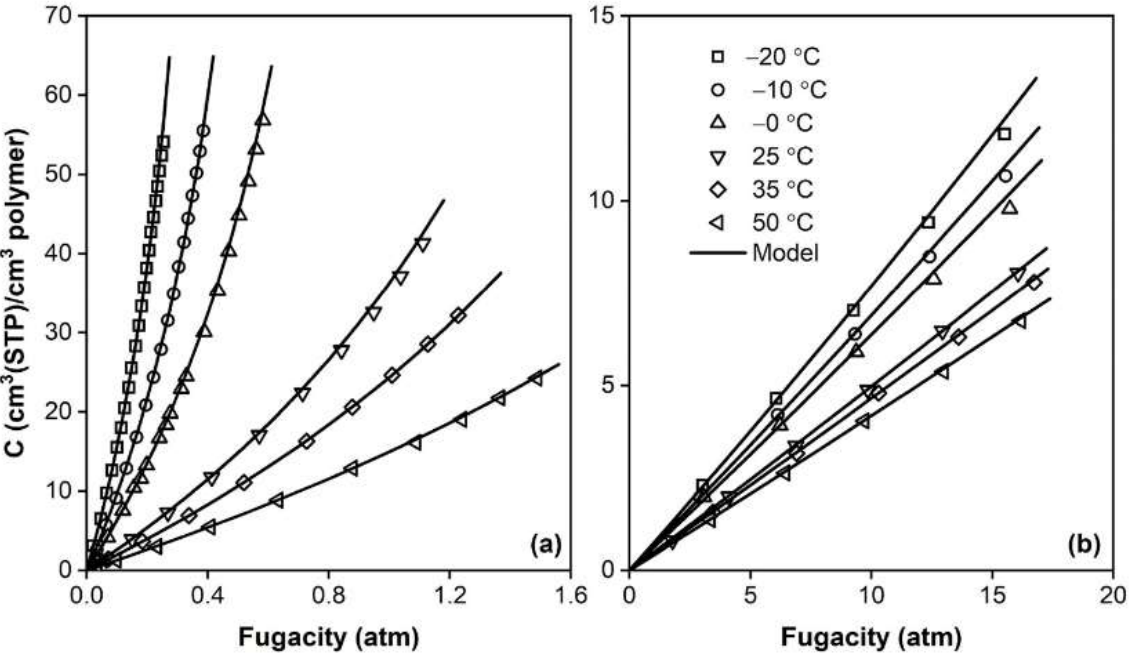
Figure 6. Example application of the PC-SAFT model to calculate ( a ) n-C 4 H 10 and ( b ) CH 4 sorption isotherms as a function of temperature [137]. Experimental data from [47]. Reprinted with permission from [137]. Copyright 2020, Elsevier.